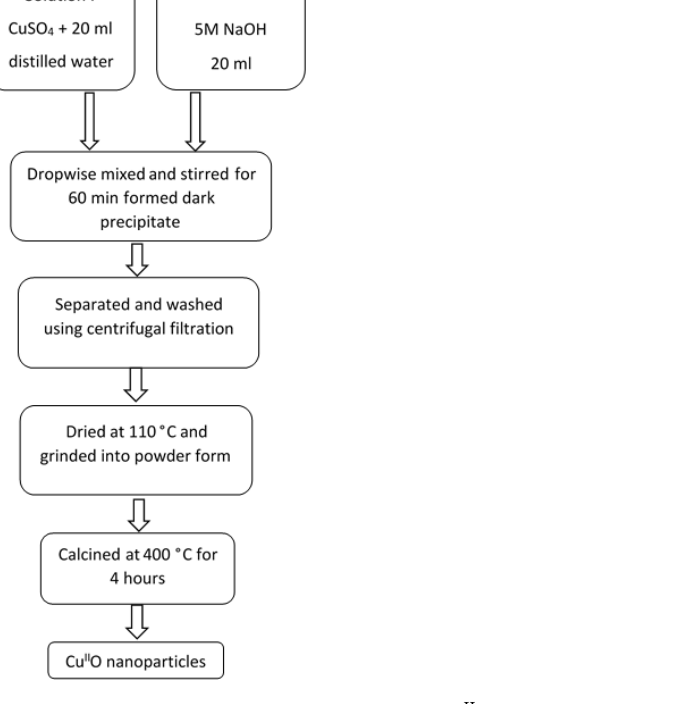
Figure 1. Flow chart representing the steps of Cu II O NPs synthesis.